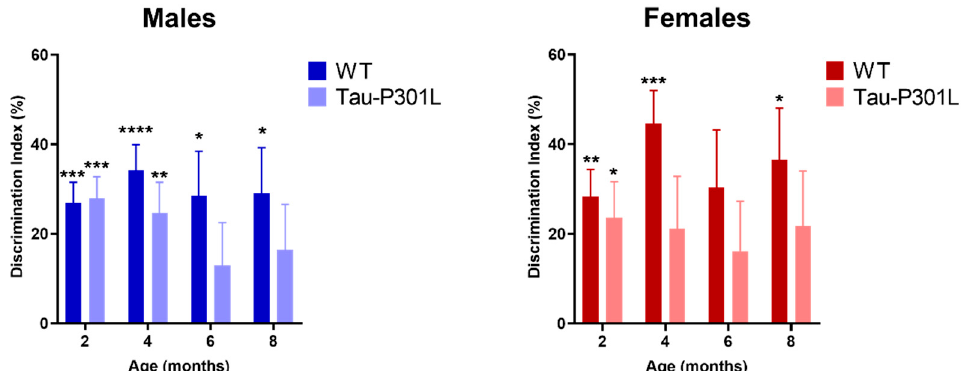
Figure 5. Deficits in recognition memory in Tau-P301L mice in the novel object recognition test (NOR). Both Tau-P301L mice and WT were evaluated at 2, 4, 6 and 8 months of age. Tau-P301L male mice ( n = 12) were not able to discriminate the novel from the familiar object at 6 months of age and Tau-P301L female mice ( n = 7) at 4 months of age. Both WT male ( n = 12) and female mice ( n = 7) were able to discriminate the novel object. The one sample t -test against 0% was used to evaluate the missing discrimination from the novel object. *: p < 0.05, **: p < 0.01, ***: p < 0.001 and ****: p < 0.0001. Data are given as mean ± SEM.